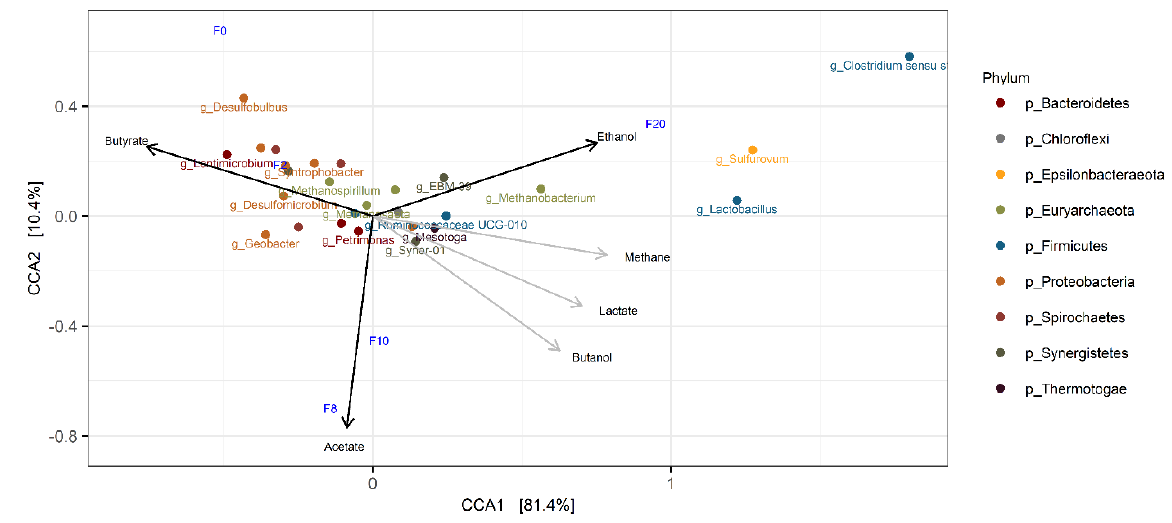
Figure 10. Canonical correspondence analysis (CCA) ordination triplot of microbial species at genus level, fermentation samples, and substrate/product concentrations using Bray–Curtis distances. The constrained ordination explains 97.4% of the variation; the corresponding Eigen values for CCA1 and CCA2 are 0.103 and 0.013, respectively. The overall solution has a p -value of 0.0083. ASVs mapped to genera were color-coded according to phyla (given in the legend); fermentation samples are depicted as labels in blue; and substrate/products are shown as arrows. Methane, lactate, and butanol (shown in grey) were not used as ordination constraints due to high collinearity with butyrate. Sample scores and product concentration scores were scaled by a factor of 0.5 and 0.8, respectively, to enhance visualization of the data.